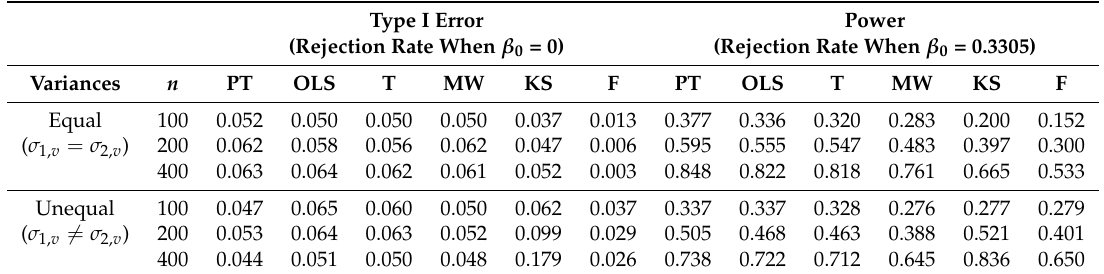
Table 1. Type I error and power of the single input case with equal and unequal error